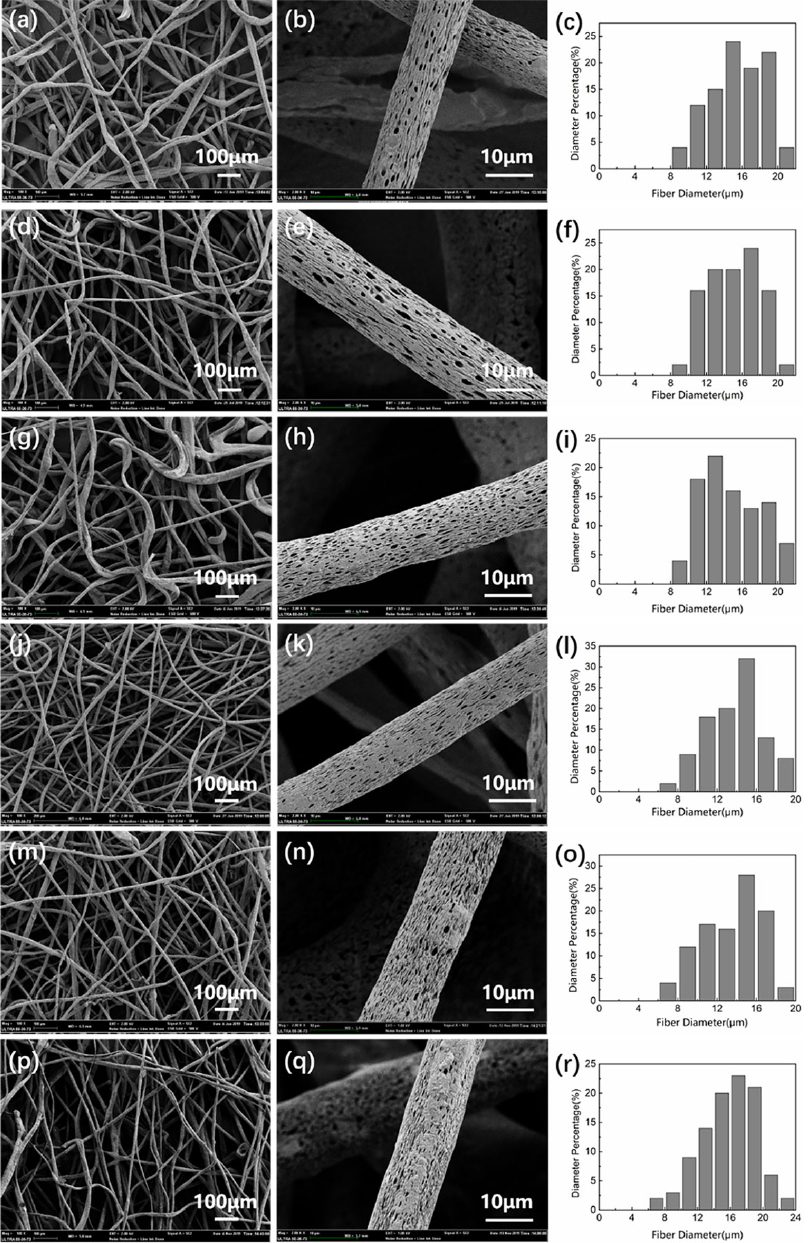
Figure 3. SEM and fiber diameter distribution of porous composite fiber membrane prepared by three kinds of modified MMT with different additions: ( a – c ) 3 wt% HCl-MMT/CA; ( d – f ) 3 wt% SDS-MMT/CA; ( g – i ) 4 wt% SDS-MMT/CA; ( j – l ) 3 wt% CTS-MMT/CA; ( m – o ) 4 wt% CTS-MMT/CA; ( p – r ) 5 wt% CTS-MMT/CA.